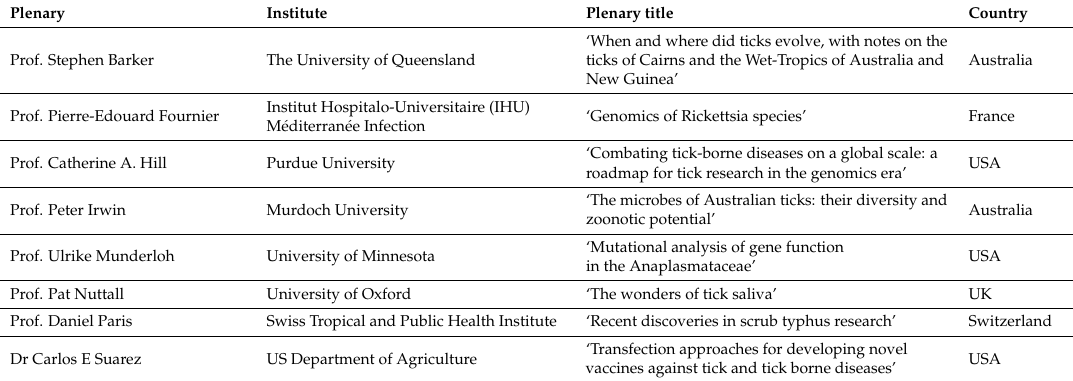
Table 2. TTP9APRC1 plenary speakers, their institutions, countries, and plenary